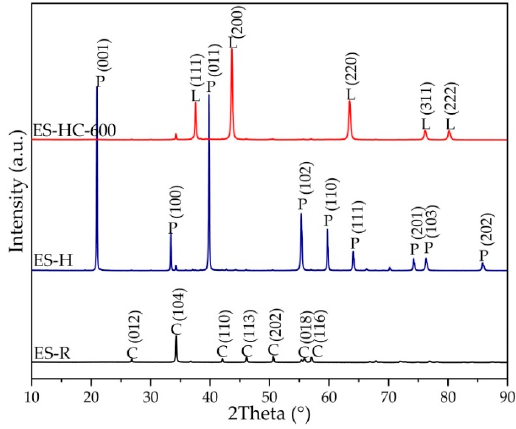
Figure 2. X-ray diffractometry (XRD) patterns of the raw chicken eggshells (ES-R), hydrated ES (ES-H), and catalyst (ES-HC-600); where: C—Calcite; P—Portlandite; and L—Lime.